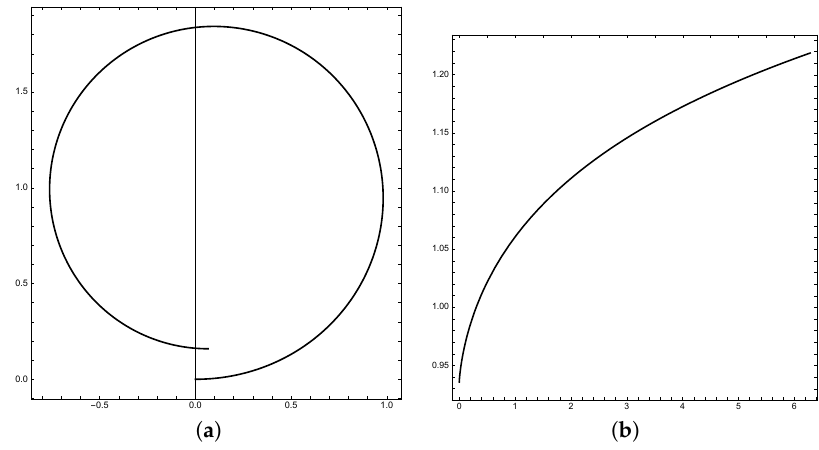
Figure 2. ( a ) Curve with ρ ( θ ) = U ( 0.1,0.1, θ ) , 0 ≤ θ ≤ 2 π , ( b ) curvature.